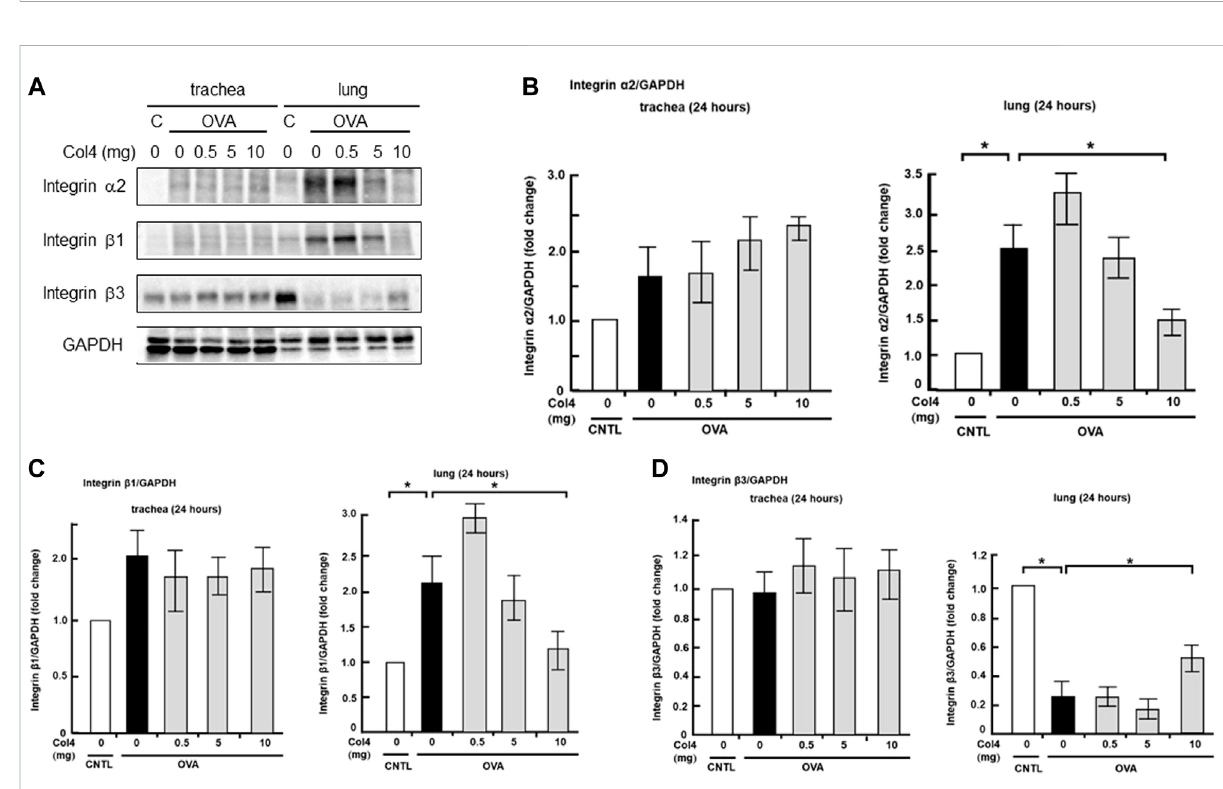
FIGURE 7 Effects of Col4 on integrin α 2, β 1, β 3, and GAPDH protein levels in ovalbumin (OVA)-sensitized and unsensitized control mice. (A) The control mice (C) and OVA-sensitized mice (OVA) were exposed to Col4 at various concentrations (0 – 10 mg). After 24 h of Col4 exposure, the trachea and lungs were sampled and integrin α 2, β 1, β 3, and GAPDH protein levels were detected. Graphs show the relative levels of integrin α 2 (B) , β 1 (C) and β 3 (D) per GAPDH compared with the control. Representative results of three independent experiments are presented. The control mice and the mice treated with 0 mg of Col4 were exposed to PBS alone at the same